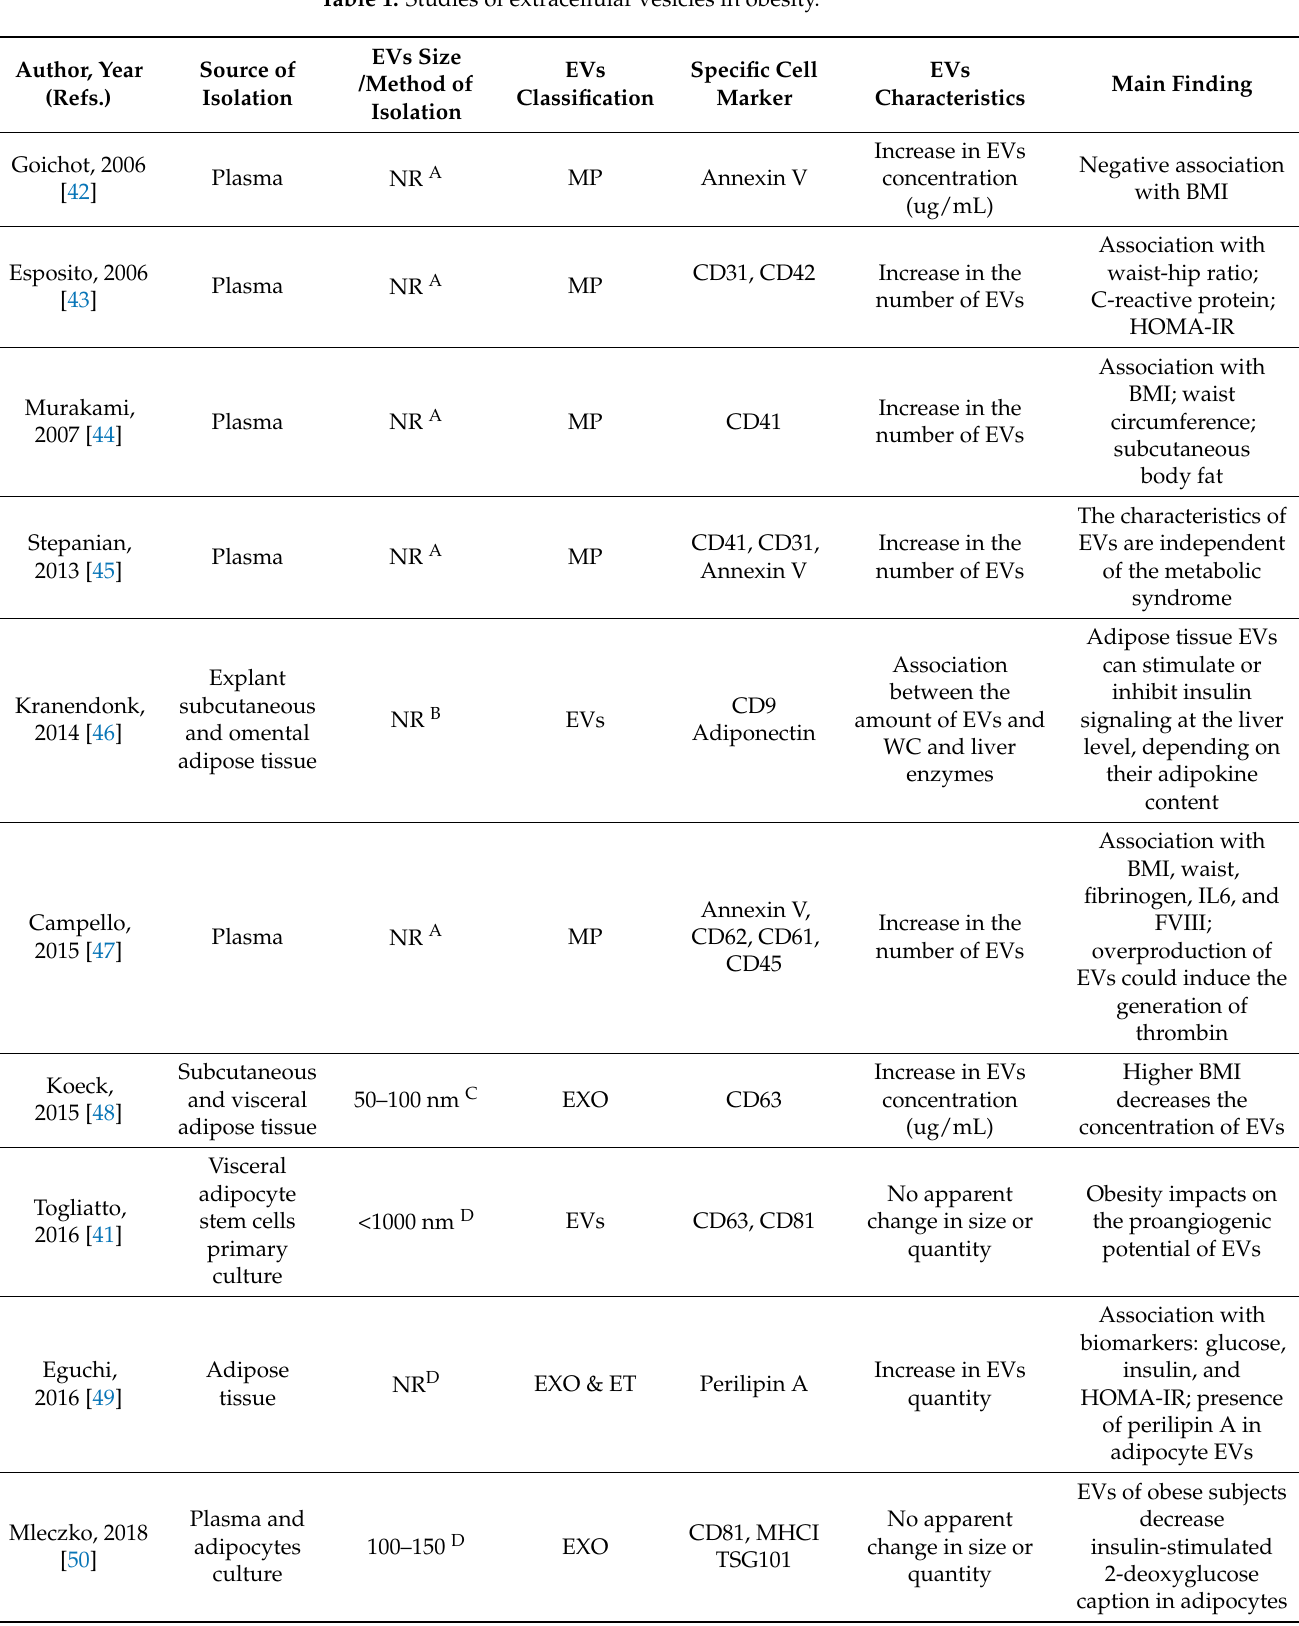
Table 1. Studies of extracellular vesicles in